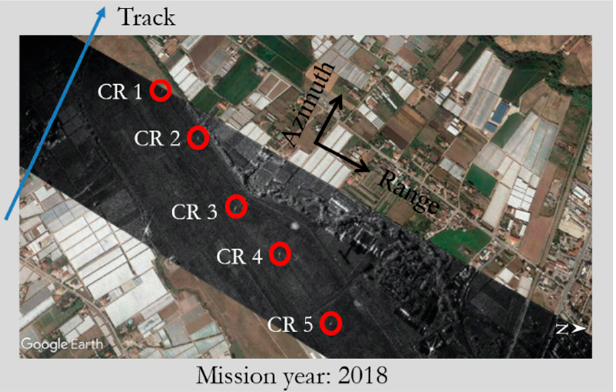
Figure 2. Relevant to the Experiments 1 and the Experiments 2. As Figure 1, with highlighted the CRs and (a pictorial view of) the tracks exploited in these experiments. Number of exploited CRs (red circles): 5. Number of exploited tracks (blue line): 1. Mission year: 2018. Remote Sens. 2020 , 12 , x FOR PEER REVIEW